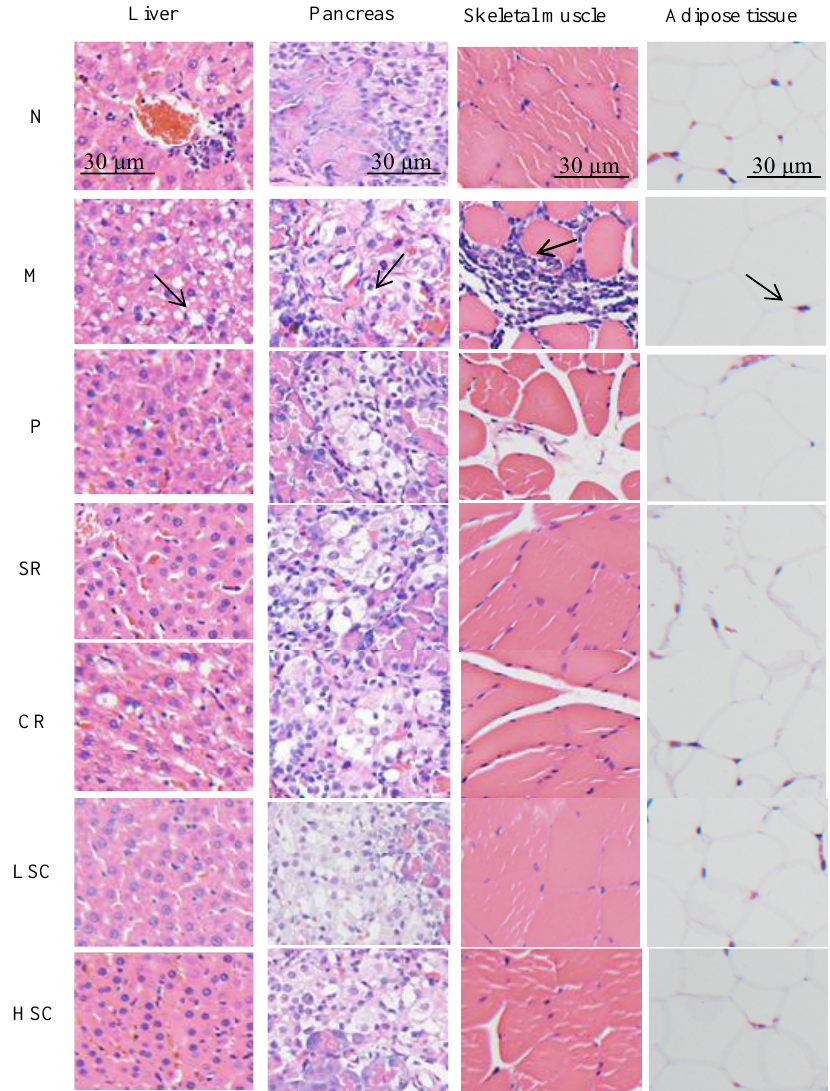
Figure 2. Histopathological observation of liver, pancreas, skeletal muscle and adipose tissue in the normal group (N), model group (M), and groups gavaged with metformin (P), scutellaria Radix (SR), coptidis Rhizome (CR), low dose of combined extracts group (LSC) and high dose of combined